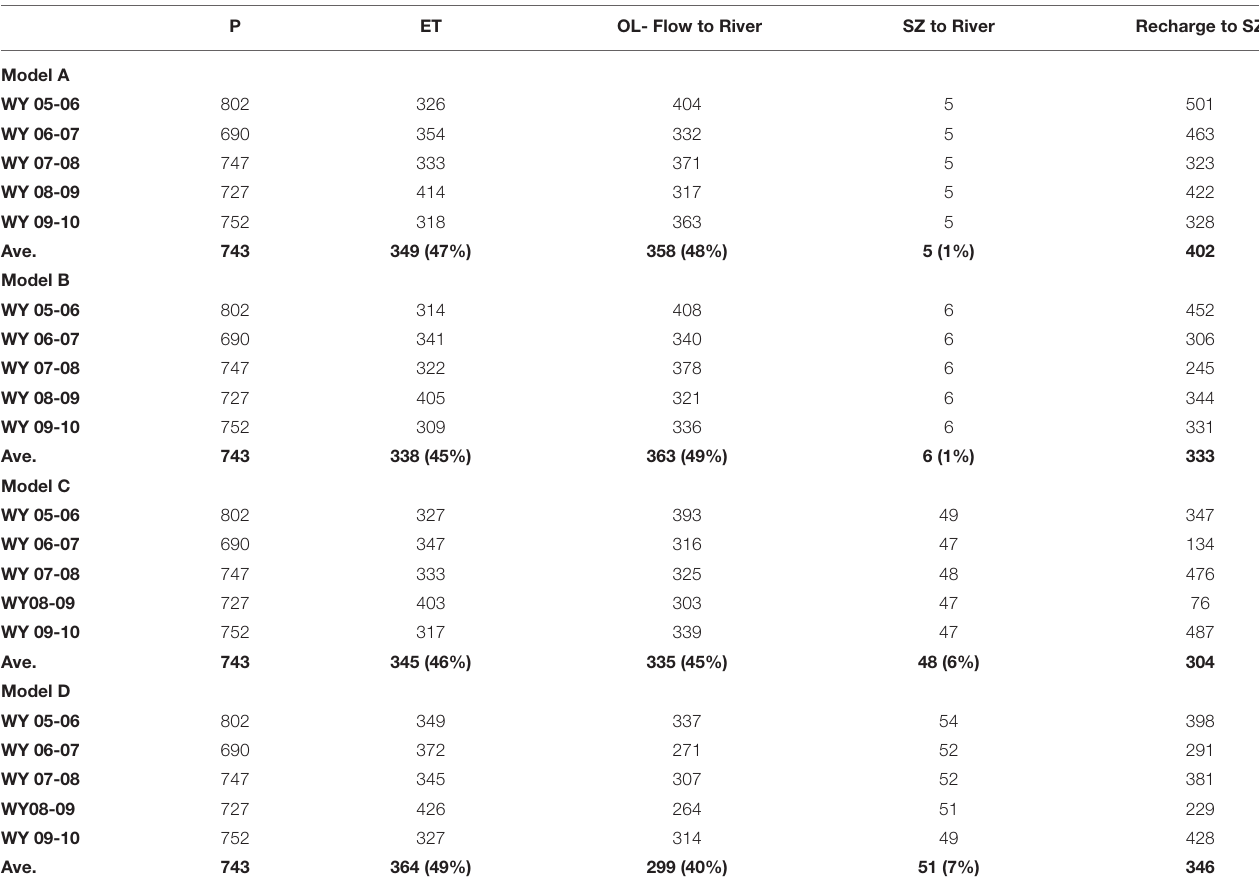
TABLE 1 | Main water balance components (mm/year) for each individual water year (WY) and the WY average (Ave.) for 2005–06 to 2009–10. Values in brackets represent % of precipitation. P ET OL- Flow to River SZ to River Recharge to